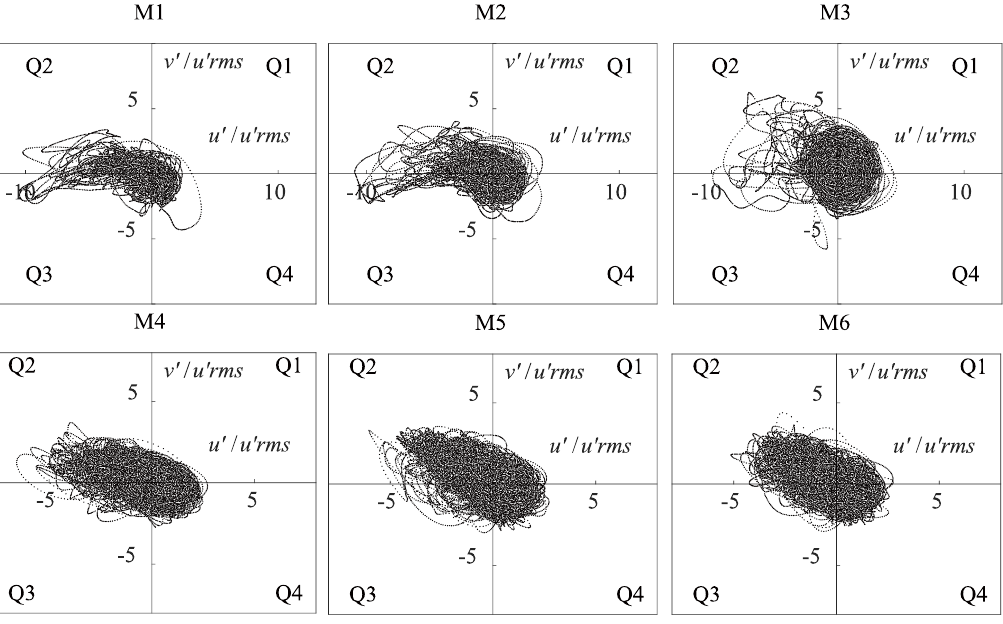
Figure 11. Quadrant analysis of the streamwise and spanwise velocity fluctuations normalized by u ’ rms for Case 2 at z / H = 0.51; Q1–Q4 represent the four quadrants, respectively.